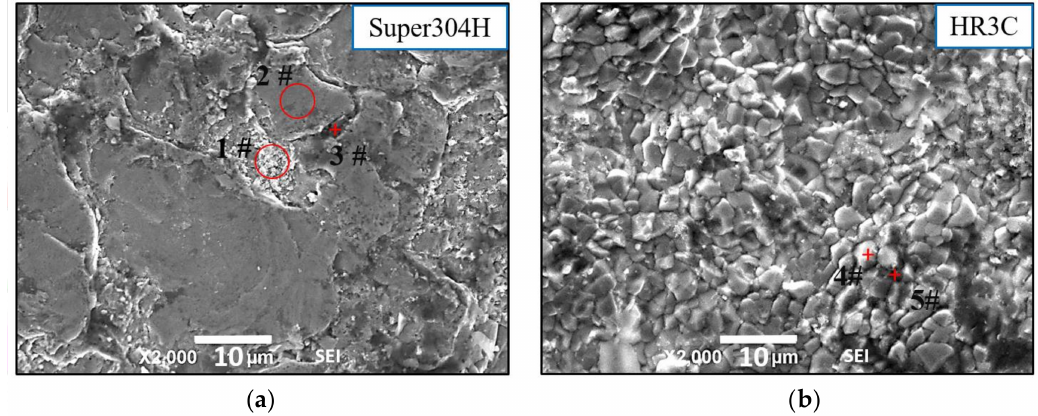
Figure 4. The SEM surface microstructure: ( a ) Super304H, ( b ) HR3C.